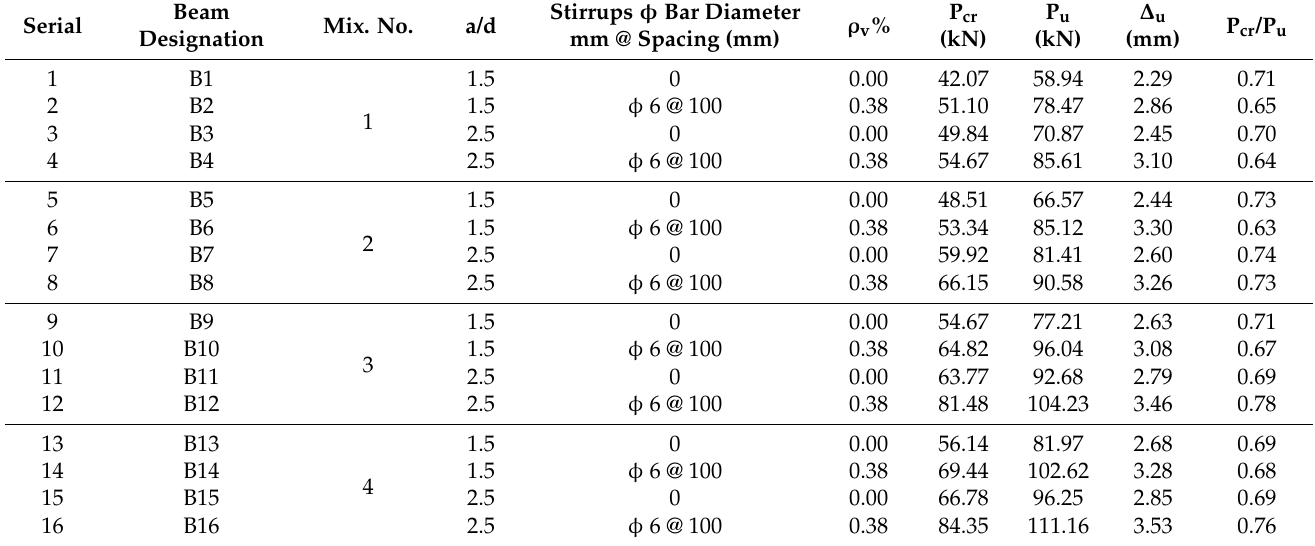
Table 5. Experimental